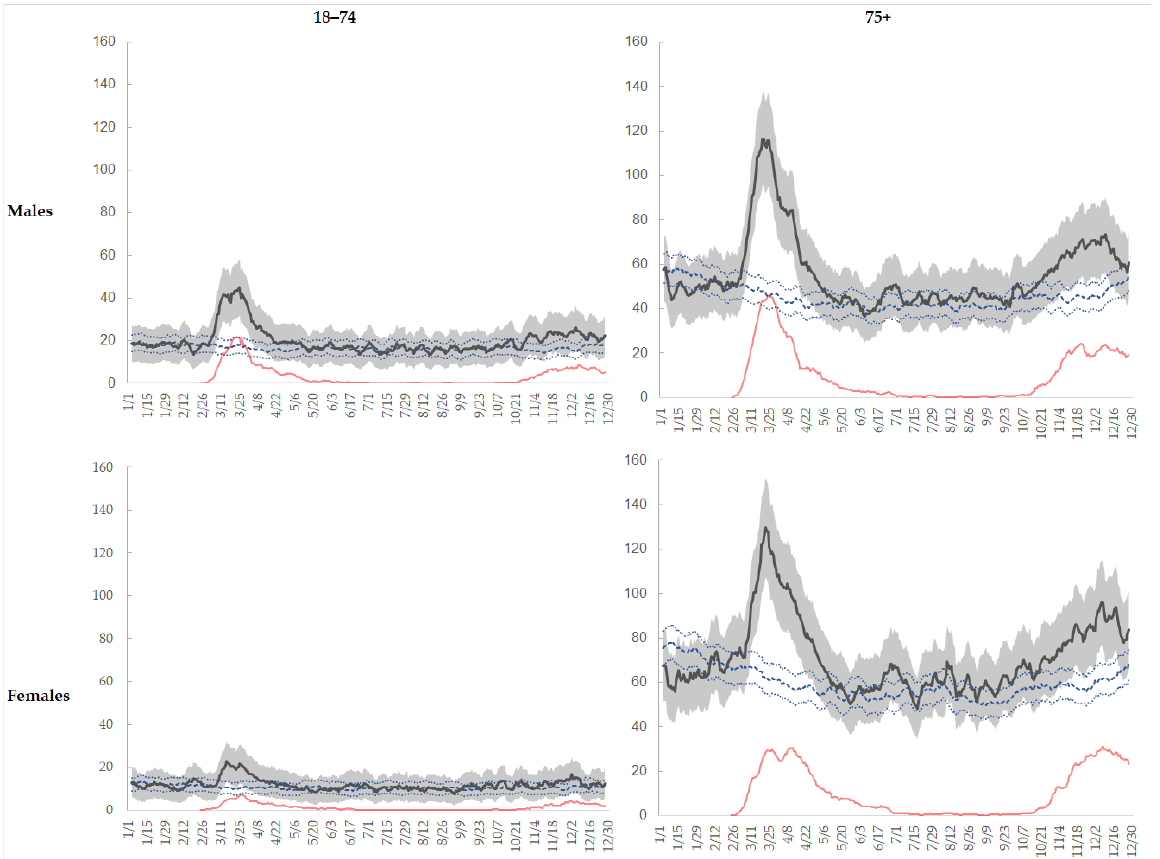
Figure 1. Number of daily total deaths (weekly moving average; on X axis month/day of month) by sex and age classes, 2020 (solid line) vs. 2015–2019 (dots) and number of daily COVID-19 deaths (weekly moving average, red line) by sex and age group, age classes, Emilia-Romagna.